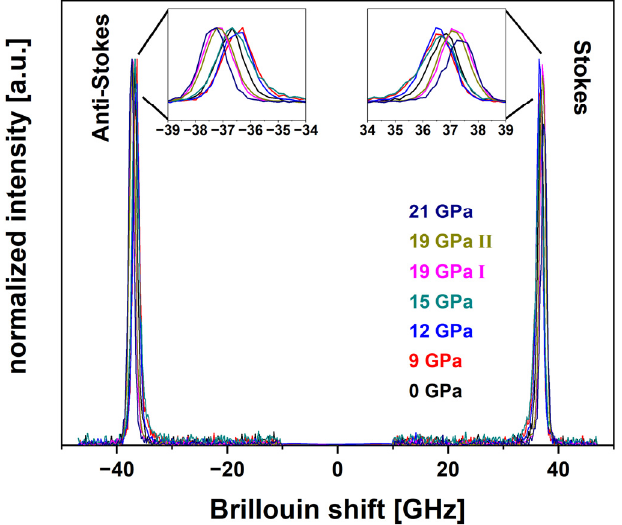
Figure 4. Brillouin spectra of the permanently densified cylinder series with P max of 0 GPa, 9 GPa, 12 GPa, 15 GPa, 19 GPa I, 19 GPa II and 21 GPa; the insets highlight the evolution of the peak positions.